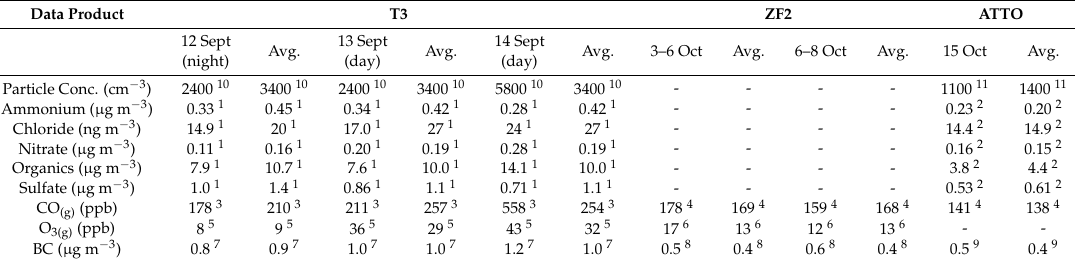
Table 2. Supporting data during sampling times for each sampling site. Values listed under sample dates are averages over that sampling period. Values in the adjacent (Avg.) column are monthly averages only for the hours coinciding with the sampling times listed in Table 1 (e.g., the average particle concentration between the hours of 8:00 and 12:00 averaged over the entire month for the Avg. column next to 13 September). Ammonium, chloride, organics, sulfate, and Black Carbon (BC) pertain to aerosol measurements whereas CO (g) and O 3(g) are gas phase measurements. Measurements with blank values were not available during the period of this study. Information regarding collection conditions can be found in Andreae et al., 2015, Artaxo et al., 2013, Martin et al., 2016 [28,34,40]. Data Product T3 ZF2 ATTO 12 Sept 13 Sept 14 Sept (day) Avg. (day) Avg. (night) Avg. Particle Conc. (cm − 3